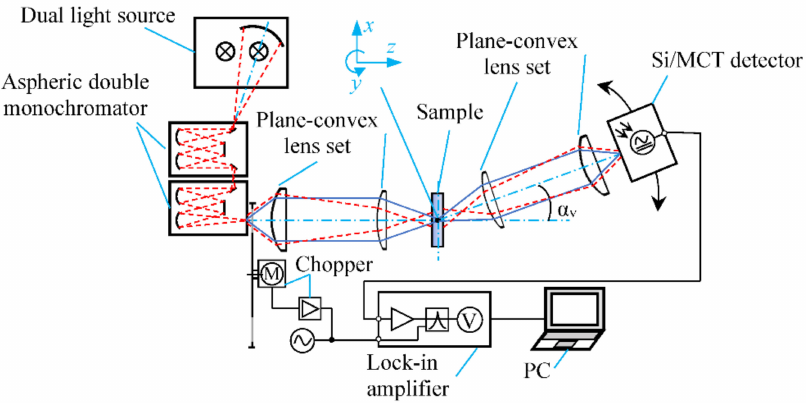
Figure 5. A spectral angle measuring system [30] to determine the thermal radiation characteristics of participation media.